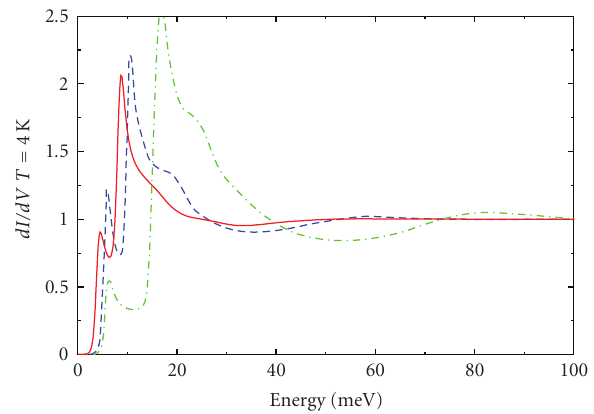
Figure 5: Calculated energy dependence of the superconductive normalized tunneling conductance at T = 4 K for LaFeAsO 0 . 9 F 0 . 1 ( T c = 27 K, red solid line), Ba 0 . 6 K 0 . 4 Fe 2 As 2 ( T c = 37 K, dash blue line), and for SmFeAsO 0 . 8 F 0 . 2 ( T c = 52K, green dash-dot line).